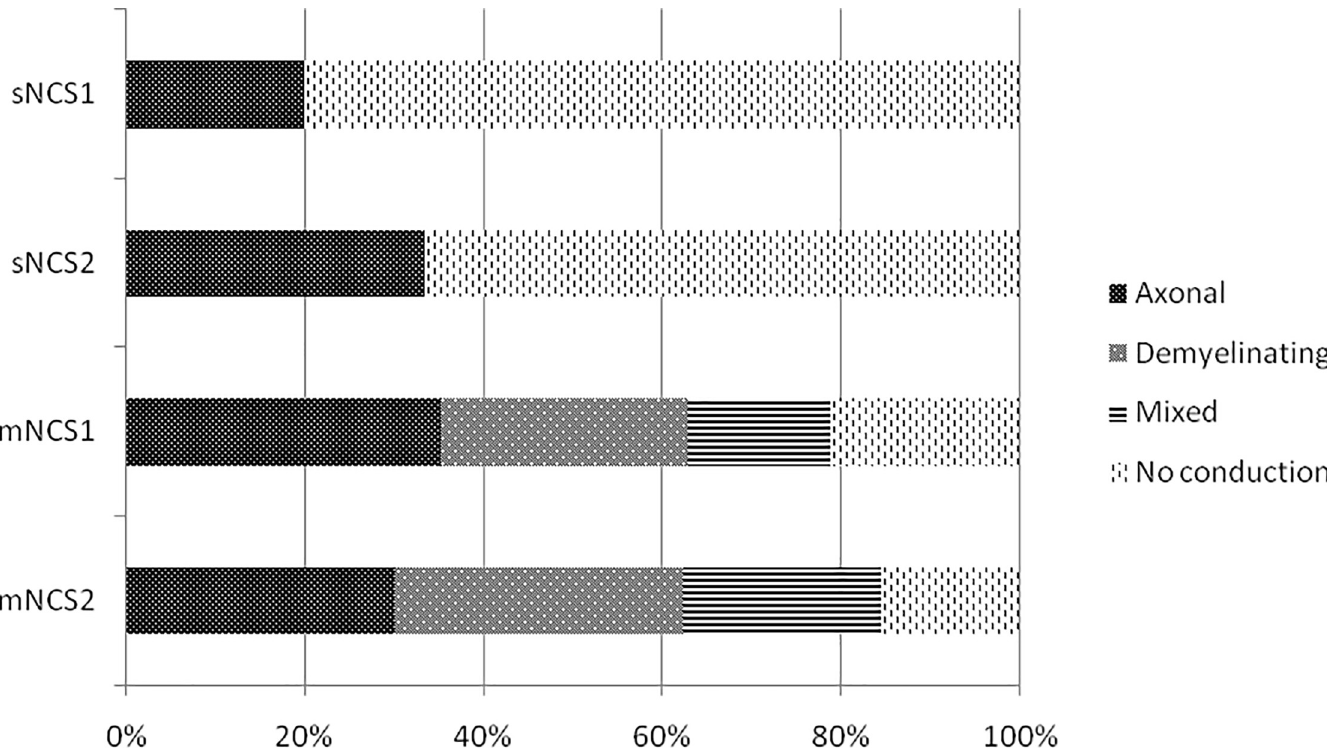
Fig 3. Nerve conduction studies (NCS) performed before and after the MDT. NCS1: NCS performed before the MDT. NCS2: NCS performed after the MDT. sNCS: sensory NCS. mNCS: motor NCS.